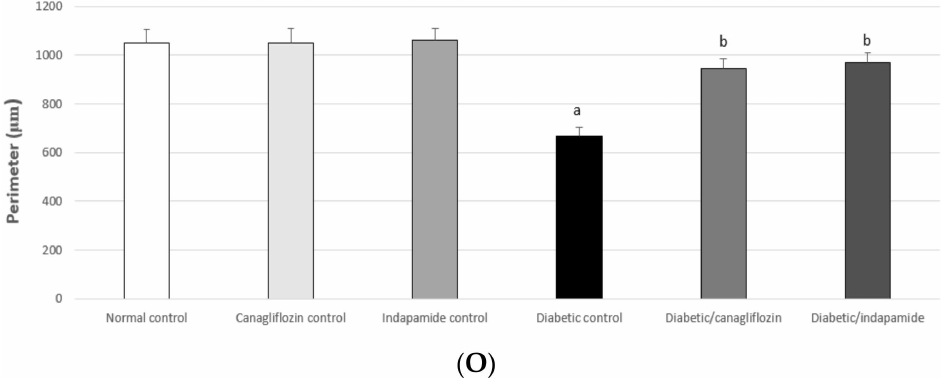
Figure 13. Adipose tissue specimens: normal ( A , B ), CANA ( C , D ), and INDA ( E , F ) CTRLs revealing the normal shape and size of the epididymal adipocytes; diabetic CTRL ( G – J ) showing congestion (arrow), decreased size of adipocytes, and macrophage infiltration (arrow heads). Marked increase in the size of the adipocytes in CANA ( K , L ) and INDA ( M , N ) treatment groups. Low magnification: 100 × bar 100; high magnification: 400 × bar 25. ( O ) Impact of daily treatment with CANA and INDA on epididymal adipocyte perimeter: oral CANA and INDA treatments were initiated once daily for 4 weeks. Data represent the mean ± S.E.M. (6 rats/group). ANOVA followed by post hoc Tukey–Kramer test at ( p < 0.05) was used for statistical comparison; a against normal CTRL, b against diabetic